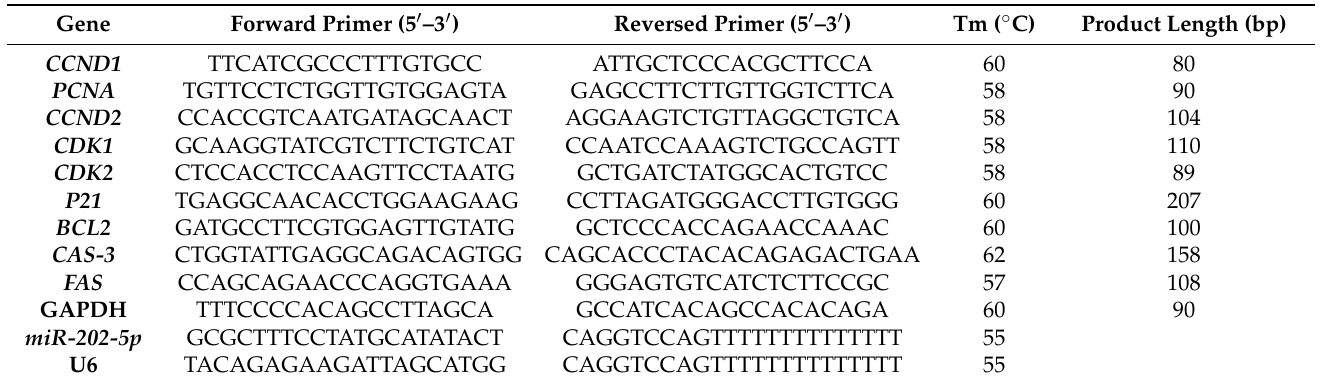
Table 1. Primer pairs for real-time quantitative